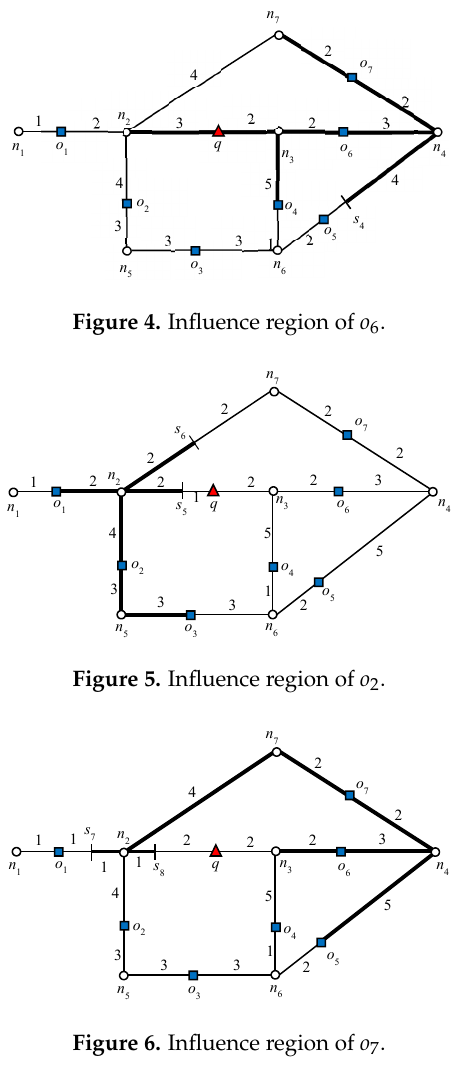
Figure 6. Influence region of o 7 .